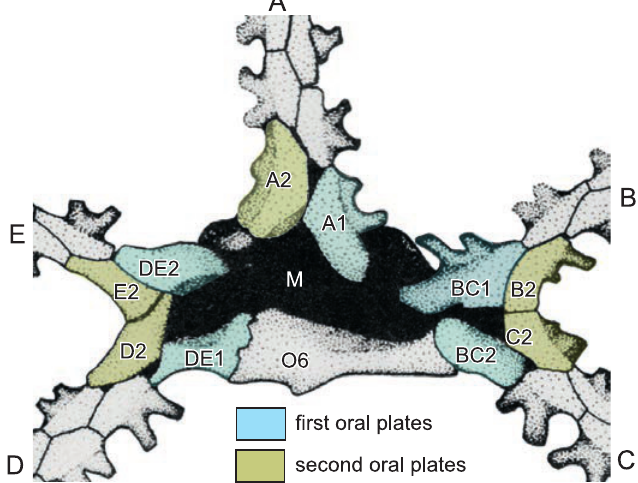
Fig. 4. Origin of Lovén’s Law in echinoderms illustrated by the oral plat- ing in edrioasteroid Walcottidiscus Bassler, 1935 (USNM 376690), early Cambrian, locality unknown. A–E, five ambulacra arranged in a 2-1-2 pattern so that three radiate from the mouth, shared DE, A, and shared BC. A1, BC1, and DE1 represent the first ambulacral plates in the three primary ambulacra. A2, BC2, and DE2 represent the second ambulacral plates. When the shared ambulacra bifurcated to give five there was no other position in which the new ambulacral plates could be added than in the acute angle between the dividing primary rays. Thus, the new plates were B2, C2, D2, and E2. Once all five ambulacra reached the stage of having two floor plates, the positions of the first plates obey Lovén’s Law as restated by Paul and Hotchkiss (2020), i.e., AR, BL, CR, DL, ER, that is the plates labelled A1, BC1, BC2, DE1, and DE2. Redrawn and modified from Paul and Smith 1984: 454, fig.